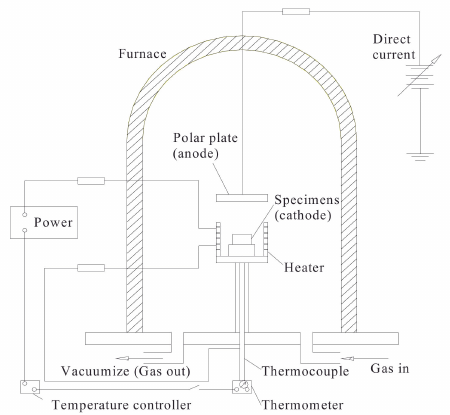
Figure 1. Working principle diagram of auxiliary heating plasma